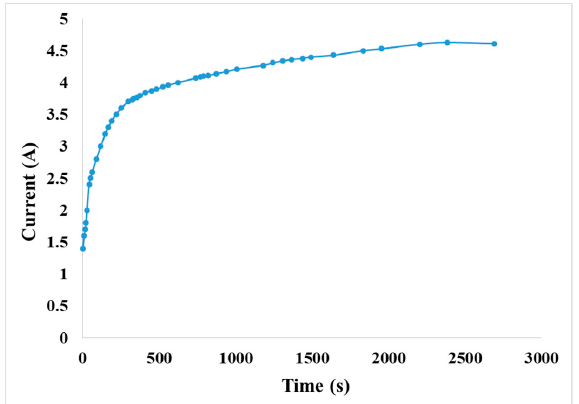
Figure 12. Voltage curve of the VRFB ion exchange.